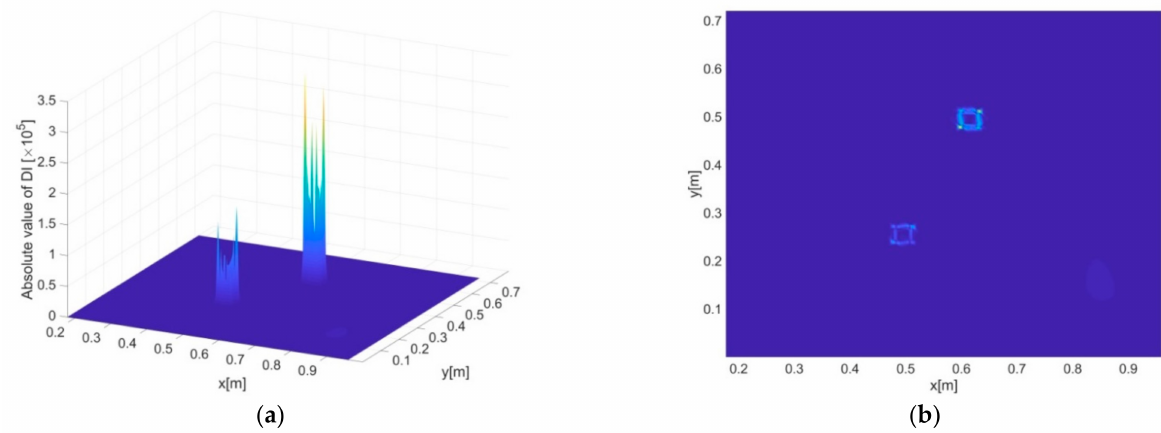
Figure 9. ( a ) Three- and ( b ) two-dimensional presentations of DI for delamination scenario